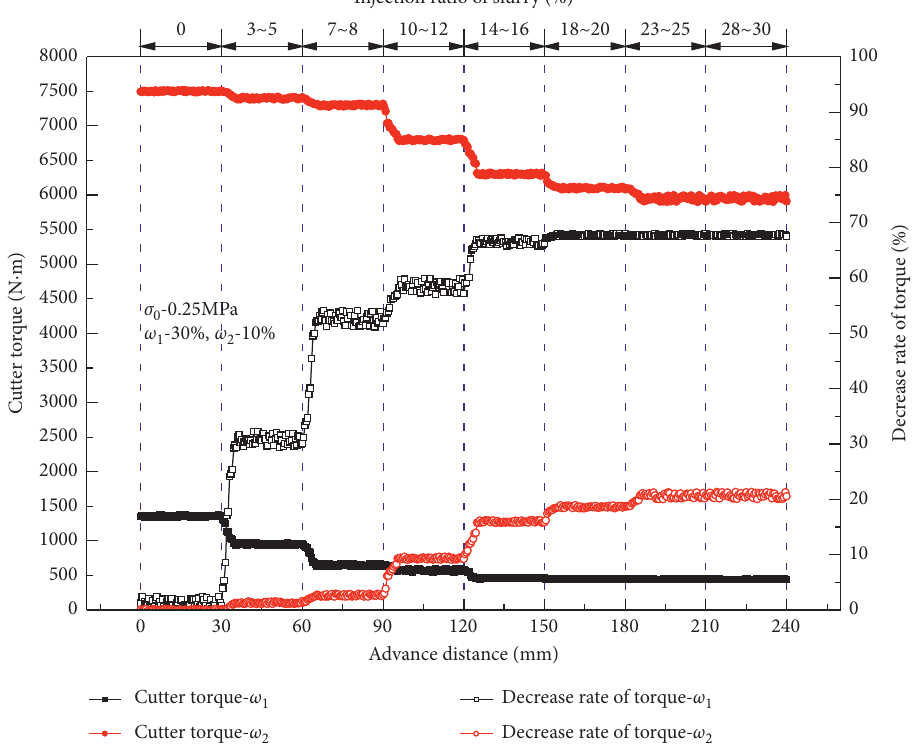
Figure 20: Effect of slurry conditioning and soil water contents on cutter torque at soil pressure